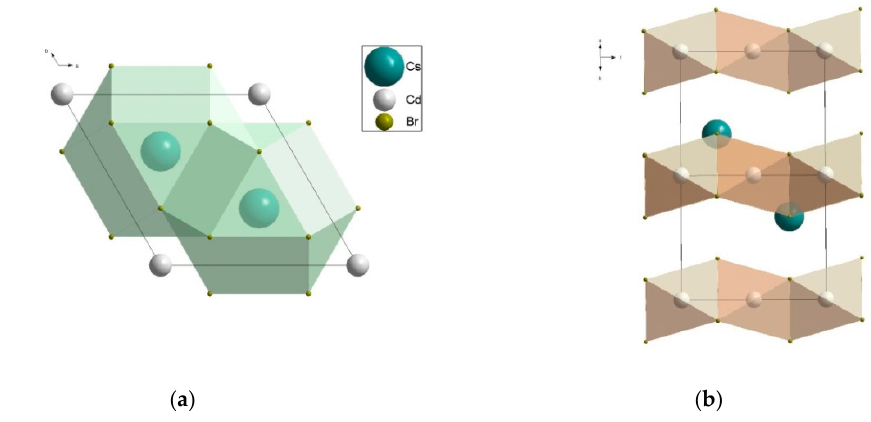
Figure 13. Crystal structure of CsCdBr 3 : ( a ) the xy projection with polyhedra for the Cs atoms; ( b ) the xz projection with polyhedra for the Cd atoms.